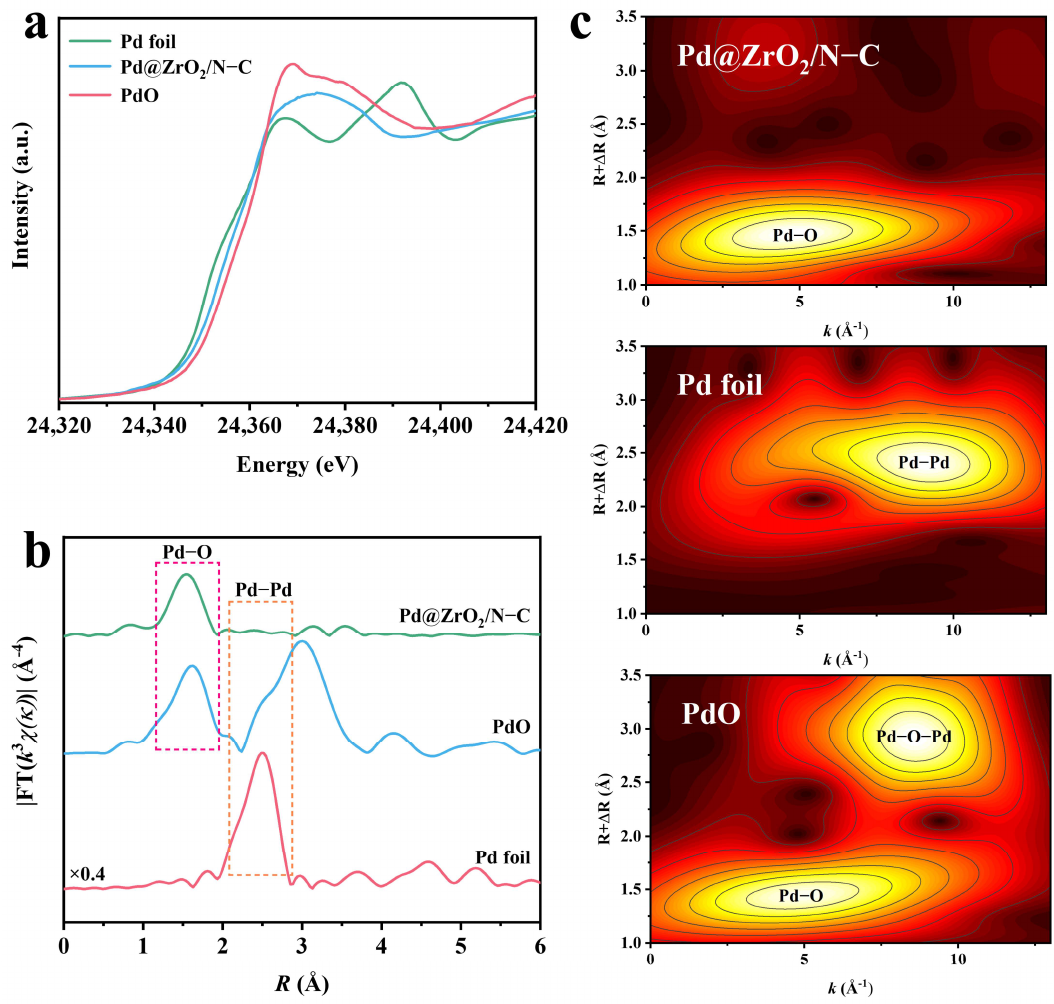
Figure 3. ( a ) XANES spectra of referenced materials and Pd@ZrO 2 /N–C for the Pd K-edge. ( b ) The k 3 -weighted Fourier transforms of Pd K-edge EXAFS spectra for Pd@ZrO 2 /N–C and referenced materials. ( c ) WT for Pd@ZrO 2 /N–C, Pd foil, and PdO, respectively.